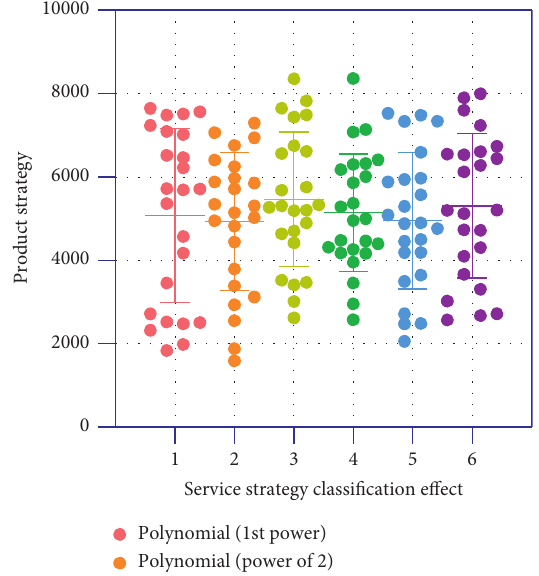
Figure 11: Market comparison scores by behavioral